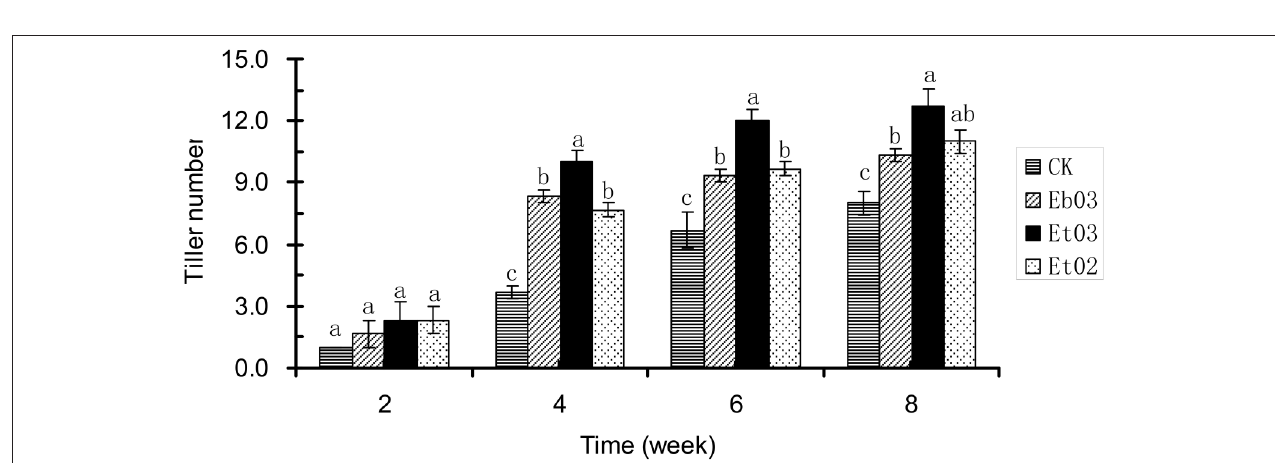
FIGURE 2 | Effects of Epichloë endophyte on tiller numbers of Elymus sibiricus . Significant differences at the 0.05 level are indicated within a time by different letters above bars. Values are means of five replicates ±